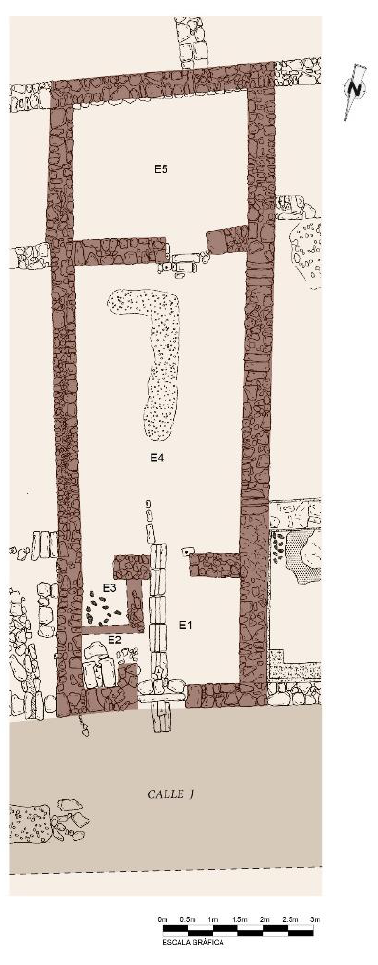
Figure 4. House 11. Latrine with access from a room for personal hygiene (E3). In other houses (102, 103, 108 and 109), 32 small rooms, open to the courtyard, in the first bay, have been found to contain charcoal (Figures 5 and 6), 33 and are interpreted as hearths, but not full kitchens, because they lack features to store and prepare food, such as benches and pantries. 34